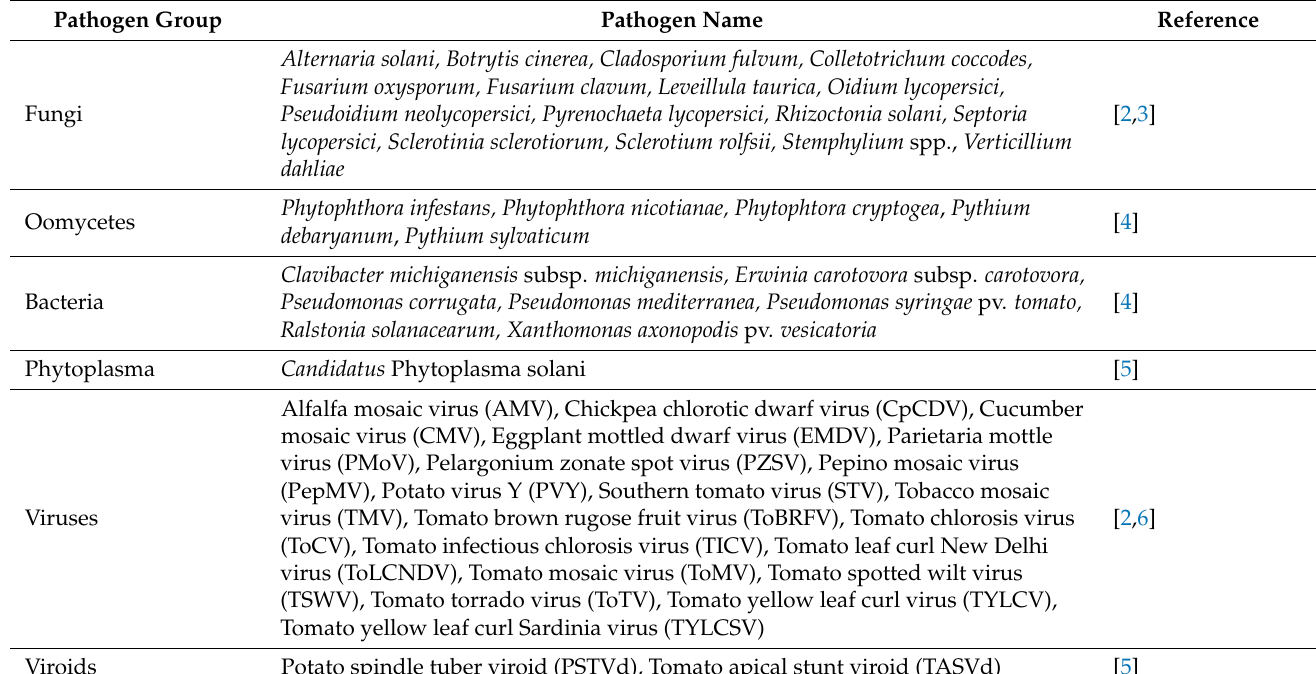
Table 1. List of tomato plant pathogens present in the Mediterranean basin.